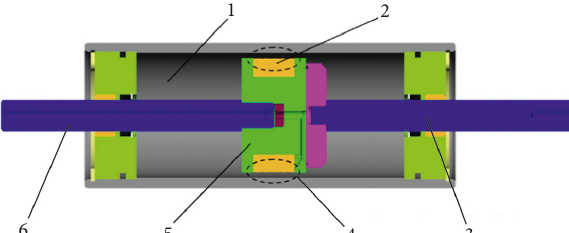
Figure 2: Double-ended MR damper.1, MRF reservoir; 2, coil; 3, front piston rod; 4, approximate flux path; 5, piston; 6, rear piston rod